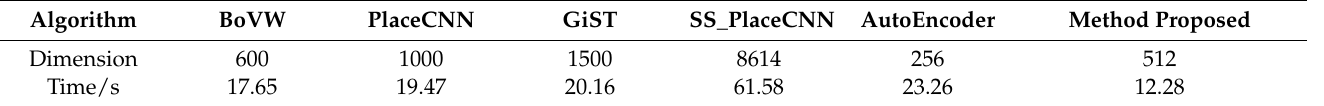
Table 4. Time performance analysis of the closed-loop